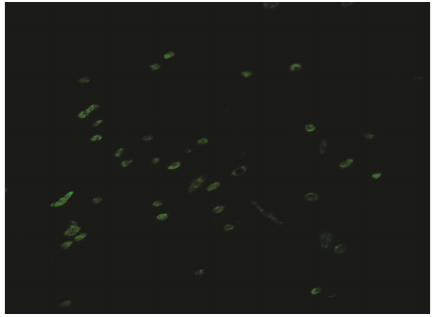
Figure 5: Identification of macrophages by CD68 immunofluo- rescence. Macrophages were differentiated from peripheral blood mononuclear cells and identified by CD68 immunofluorescence staining. Magnification: